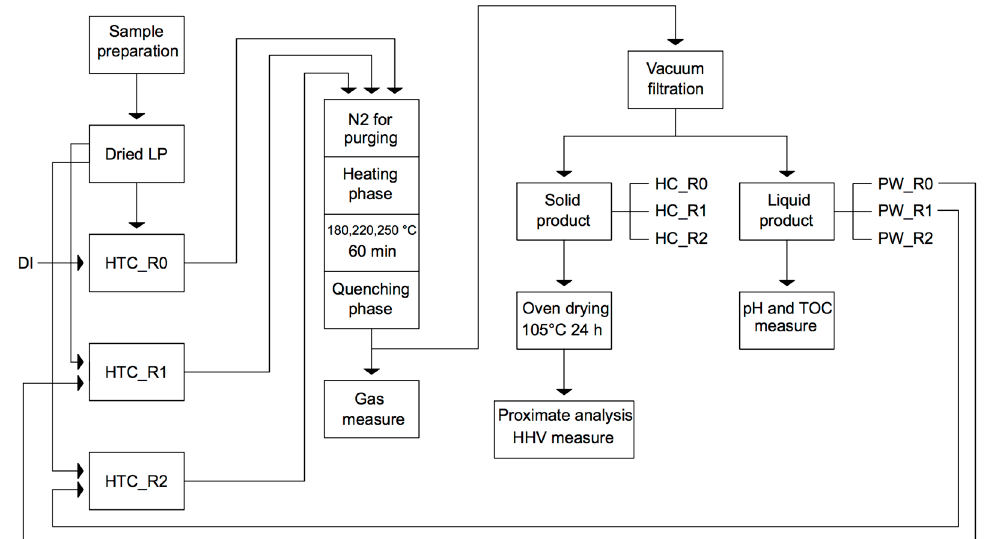
Figure 1. Typical trends of temperature during hydrothermal carbonization (HTC) runs performed at 180, 220, and 250 °C.